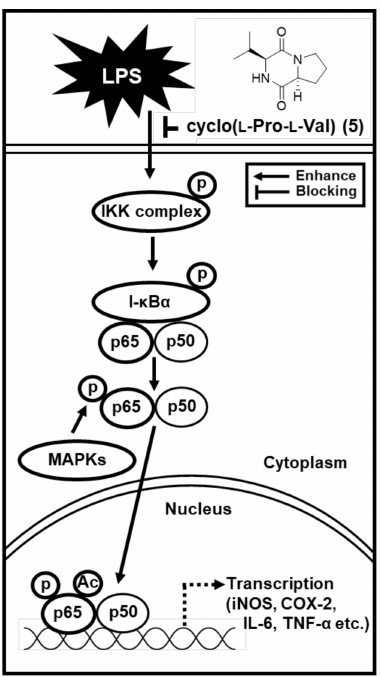
Figure 6. Schematic illustration of the mechanism for the potential role of compound 5 isolated from M. alba fruits in inflammatory responses. LPS, lipopolysaccharide; p, phosphorylated; IKK, I κ B kinase alpha; I κ B α , inhibitor of kappa B alpha; p56 and p50, cellular proteins; MAPK, mitogen- activated protein kinase; Ac, activated; TNF- α , tumor necrosis factor alpha; IL-6, interleukin 6; COX-2, cyclooxygenase-2; iNOS, inducible nitric oxide synthase.